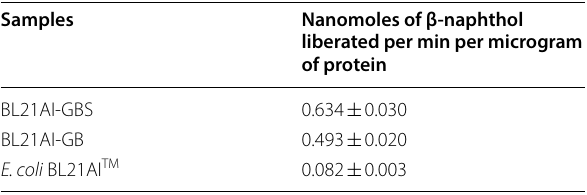
Table 2 Carboxylesterase activity of the CPS of BL21AI- GBS, BL21AI-GB, and E. coli BL21AI TM